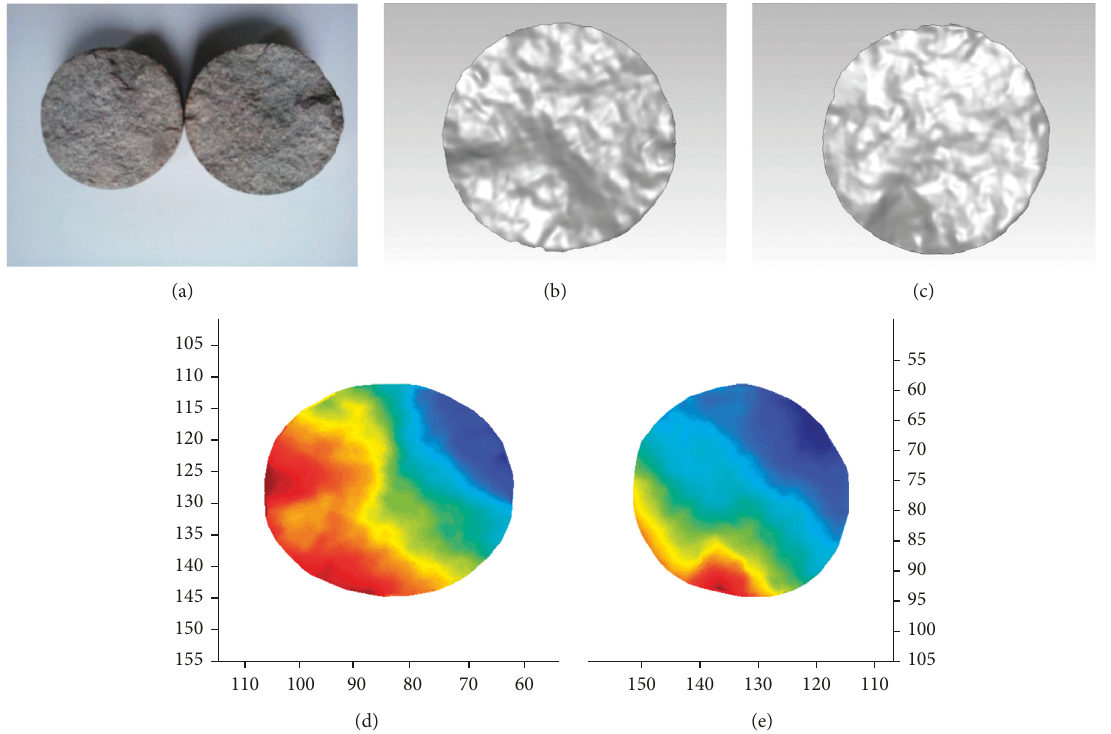
Figure 5: Reconstruction of surface topography of discontinuity for the natural rough rock joint surface model (sample B5). (a) Sample No. B5; (b) preprocess of the upper surface; (c) preprocess of the lower surface; (d) 3D reconstruction of the upper surface; (e) 3D reconstruction of the lower